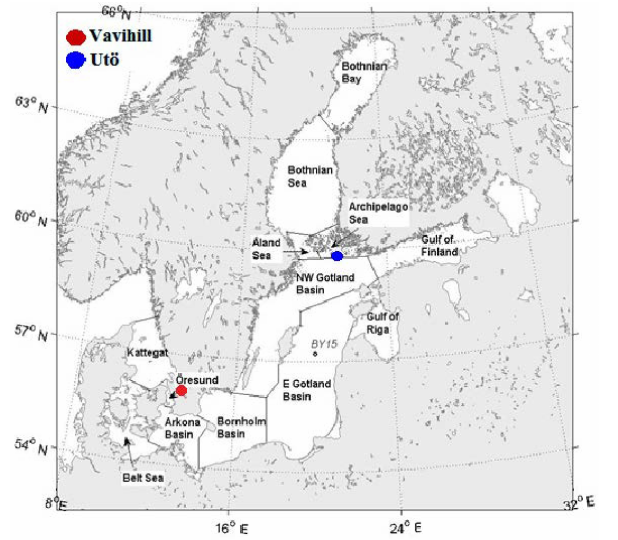
Figure 2. The division of the basins of the Baltic Sea–Skagerrak system. OR: Øresund; GO: Eastern Gotland Basin; AL: Åland Sea; BE: Belt Sea; NW: Northwest Gotland Basin; AS: Archipelago Sea; AR: Arkona Basin; GR: Gulf of Riga; BS: Bothnian Sea; KA: Kat- tegat; BH: Bornholm Basin; GF: Gulf of Finland; and BB: Bothnian Bay. Dots represent the measuring stations at Vavihill and Utö. The figure is redrawn from Omstedt et al.